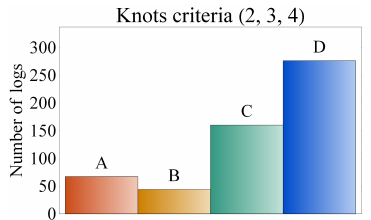
Figure 6. Results of visual grading with only the knot characteristics (2, 3, 4).